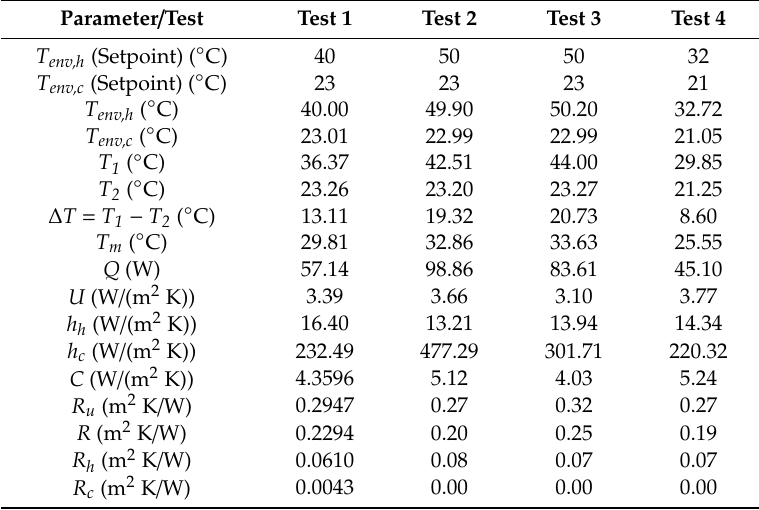
Table 3. Heat transfer quantities for Wall System